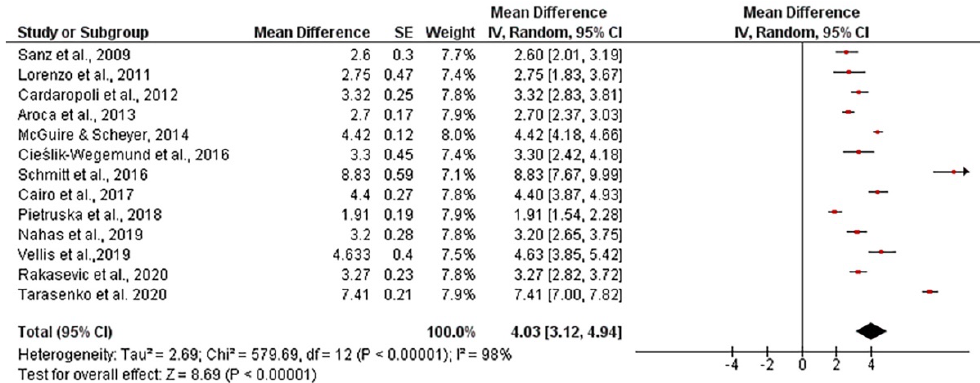
Figure 4. Non-randomized clinical trial quality assessment using ROBINS-I tool [26]. ( a ) Risk of bias summary: studies were considered as having serious (red); moderate (yellow) or low (green) risk of bias. ( b ) Risk of bias graph each risk of bias item presented as percentages across all included studies.